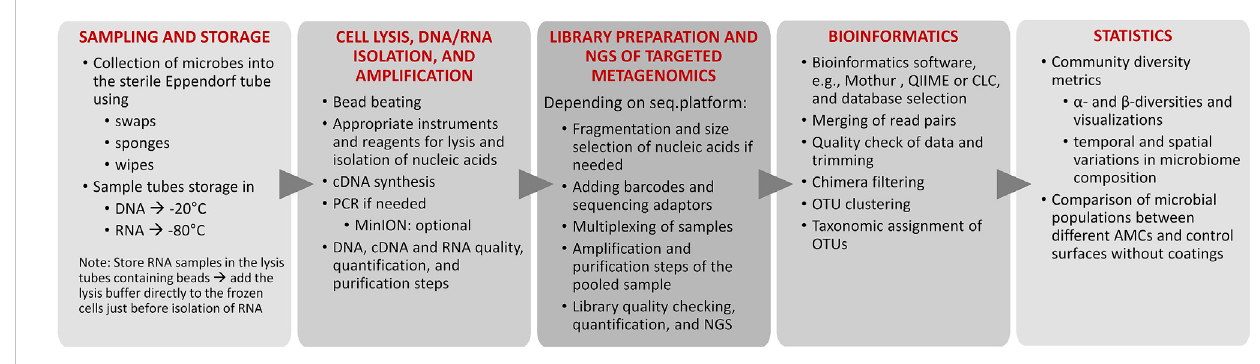
FIGURE 3 Work fl ow for a targeted metagenomic and metatranscriptomic NGS of 16S rRNA. After isolation and ampli fi cation of nucleic acids, the concentrations, and quality of the products are checked using, for example, a Qubit fl uorometer and TapeStation (or Bioanalyzer), respectively. Long-read sequencer NanoPore MinION has easier steps for library